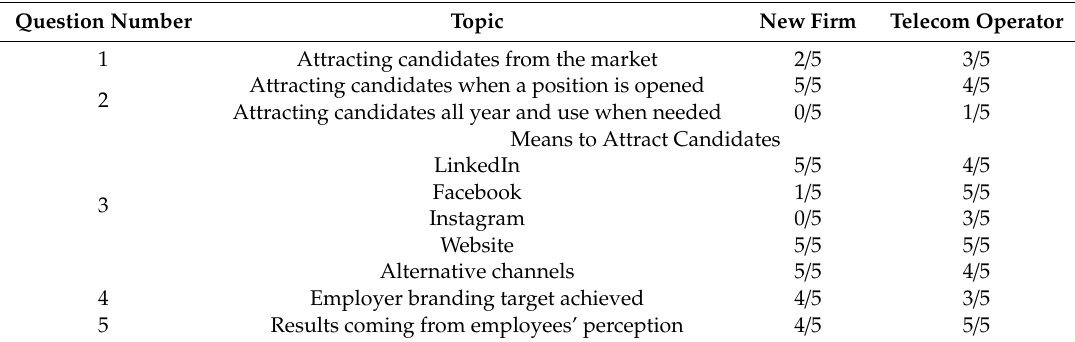
Table 2. Attracting employees and employer